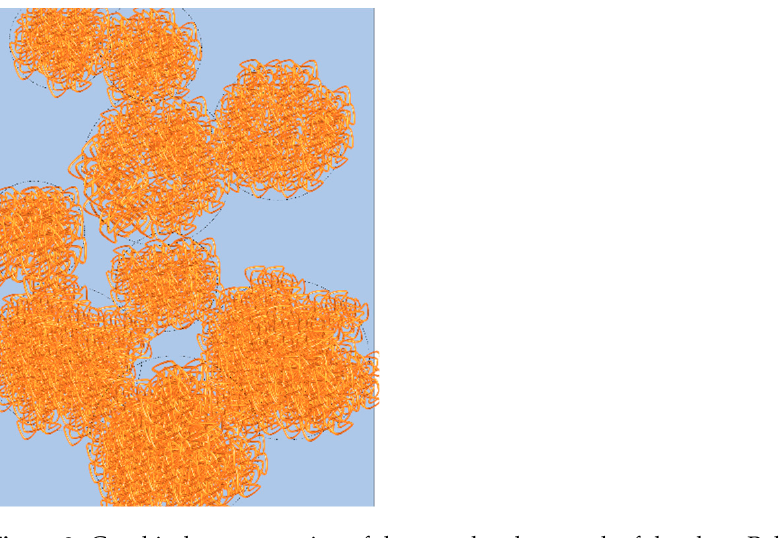
Figure 8. Graphical representation of the percolated network of droplets. Polymer rich phase in represented in orange and polymer poor phase in blue.